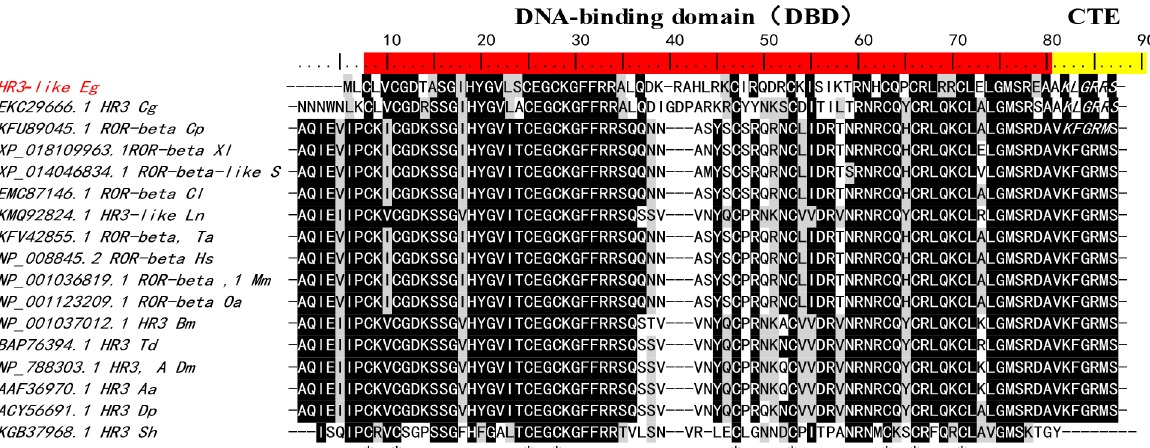
Figure 1. Sequence alignment of the DNA-binding domain (DBD) and its C-terminal extension (CTE ) in the E. granulosus EgHR3- like protein (ART84255.1) with homologs from other species. The conserved residues of DBD are highlighted in red. The conserved residues of CTE are highlighted in yellow. The conserved 8 cysteines of two C4-type zinc fi ngers are indicated with * . The GRIP-box in CTE is indicated by amino acid residues KXGRZS in italics. Sequences used for the alignment are shown in Table